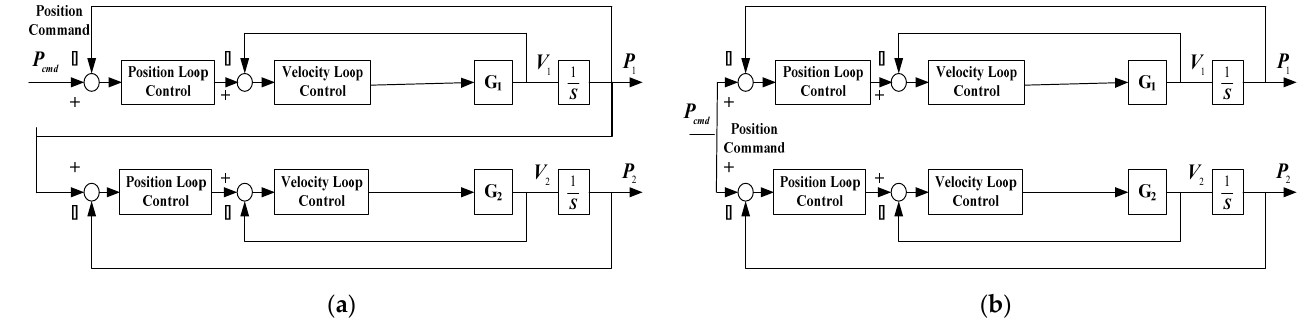
Figure 1. Typical methods to synchronize the motion in gantry robots: ( a ) cascade control method; ( b ) parallel control method.